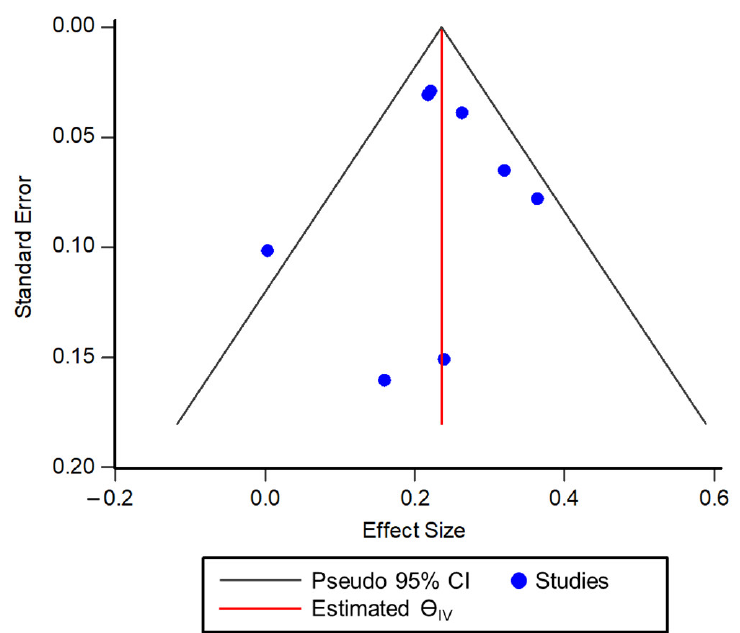
Figure 4. Funnel plot for visual depiction of publication bias among the studies included in the meta-analysis.